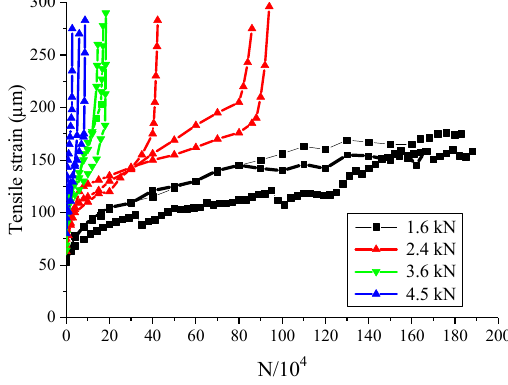
Figure 13. Process of strain evolution.